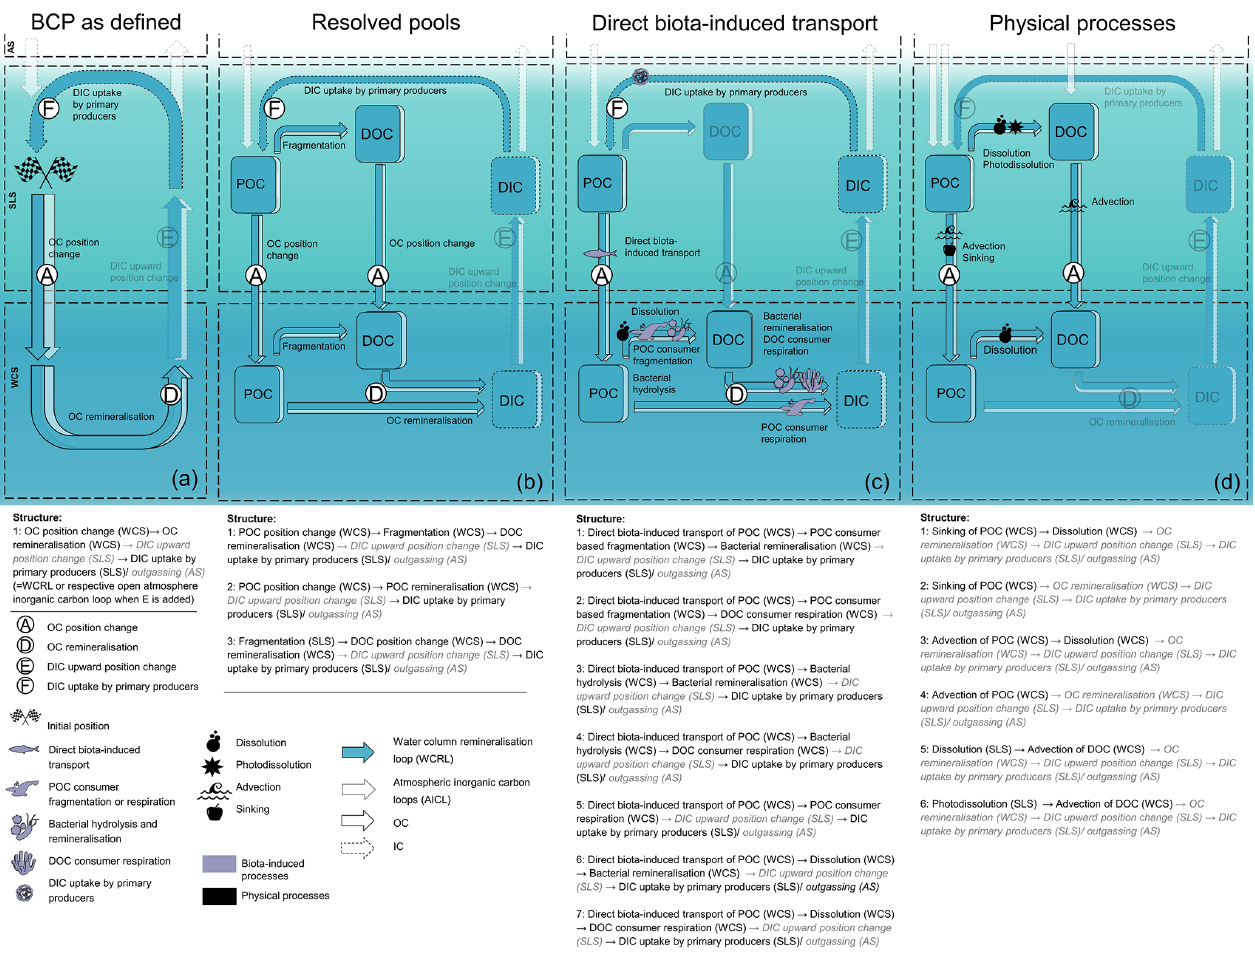
Figure 3. The illustration of the BCP defined by Giering and Humphreys (2020) shown with our concept. Panel (a) shows the superordinate BCP structures based on the definition. Panel (b) additionally resolves involved pools. Panel (c) and (d) resolve choices of processes: (c) pathways with direct biota-induced transport and (d) pathways with only physical processes. Functional segments that are transparent, grey, or written in italic font are not explicitly included in the definition of the BCP or the selected pathways. Note that all structures are part of the WCRL or AICL when adding functional segment E to (a) – (c) and D, E, and F to (d) . Note further that panel (d) only belongs to the defined BCP if functional segments D and F are